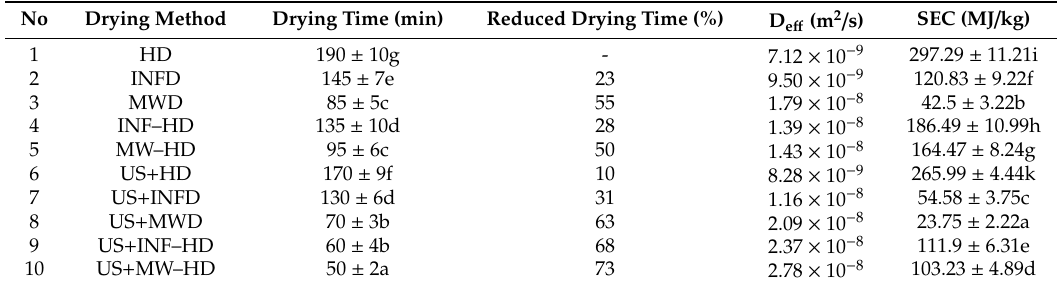
Table 4. Influence of the di ff erent drying methods on the drying parameters of